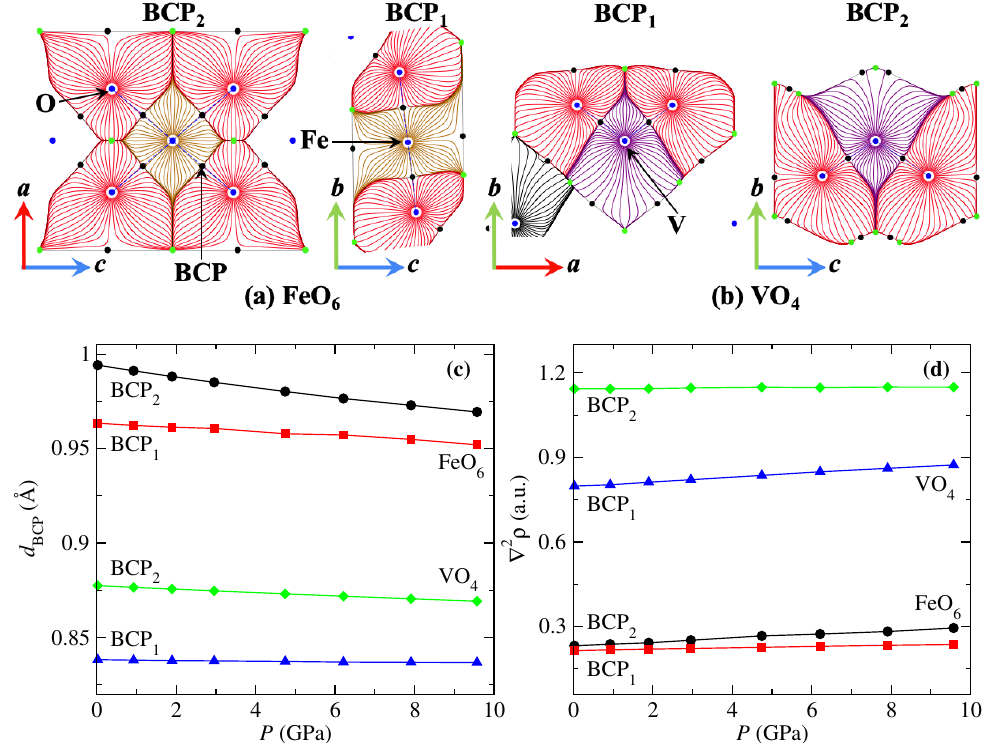
Figure 4. Gradient vector field of the electron density ( ∇ ρ ) for ( a ) FeO 6 and ( b ) VO 4 polyhedra. ( c ) Evolution of the interatomic distances from the cations to the critical bond points and ( d ) Laplacian of the charge density at the critical bond point as a function of pressure for FeVO 4